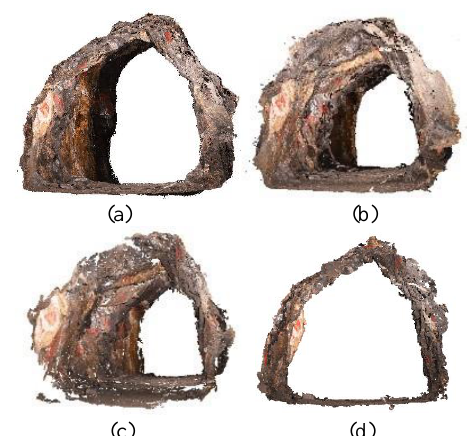
Figure 7. Dense point cloud. (a): single line based on deep learning; (b): double line based on deep learning; (c): double line based on SfM+PMVS. (d): single line based on SfM+PMVS.